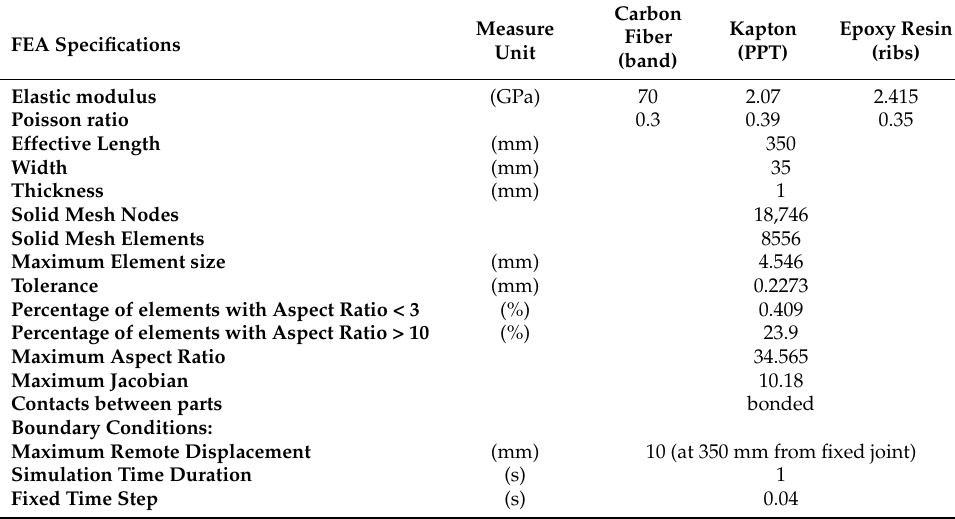
Table 3. FEA parameters.